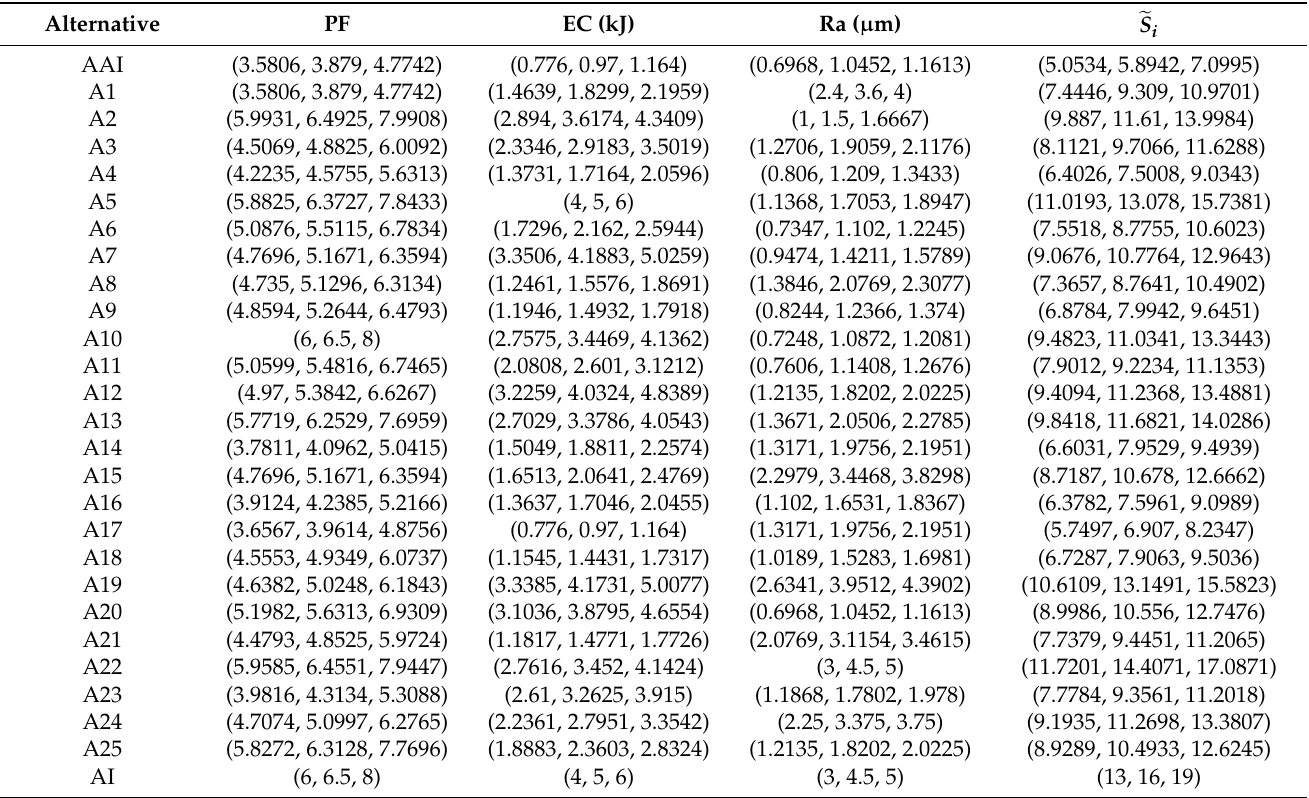
Table 4. Fuzzy weighted normalized decision matrix and (cid:101) S i values (case study